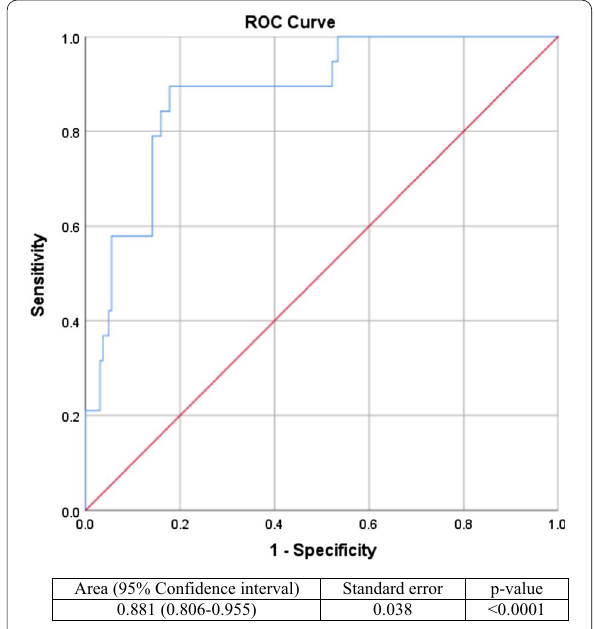
Fig. 1 Receiver operating curve to assess discrimination of the